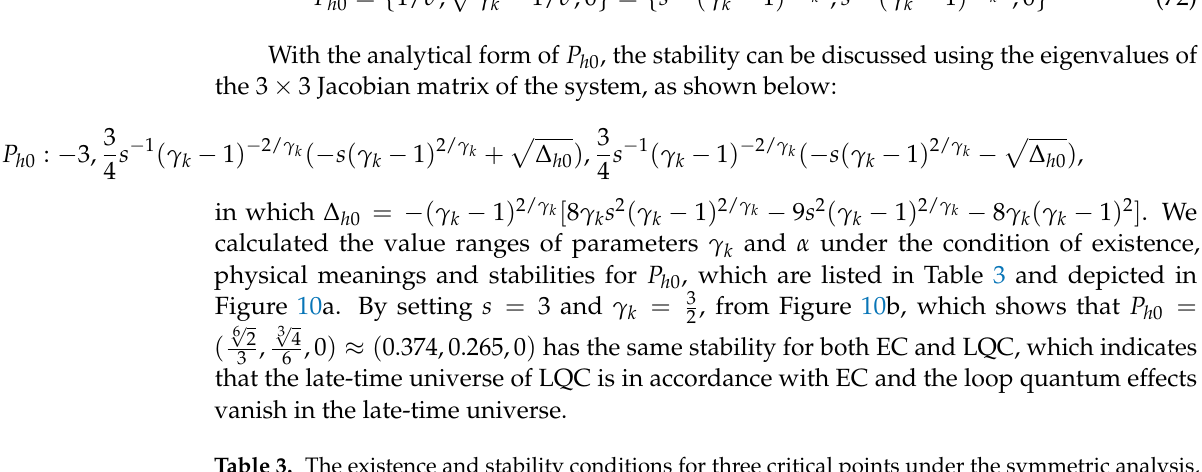
Table 3. The existence and stability conditions for three critical points under the symmetric analysis, the cosmological quantities in form of the parameters γ k , Γ and α